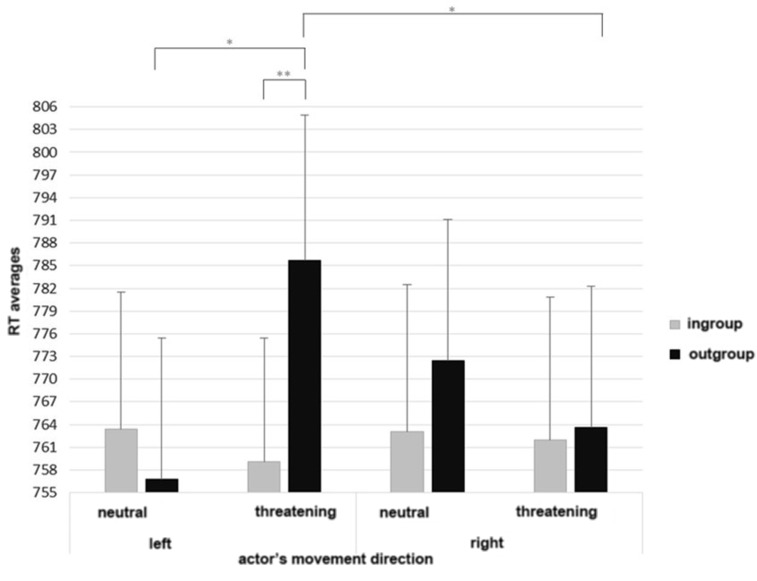
Three-way interactions between membership, actor’s movement direction, and object valence (Total Response Times). Asterisks highlight significantly different means comparisons (∗p < 0.05, ∗∗p < 0.01, ∗∗∗p < 0.001). Error bars represent standard errors.